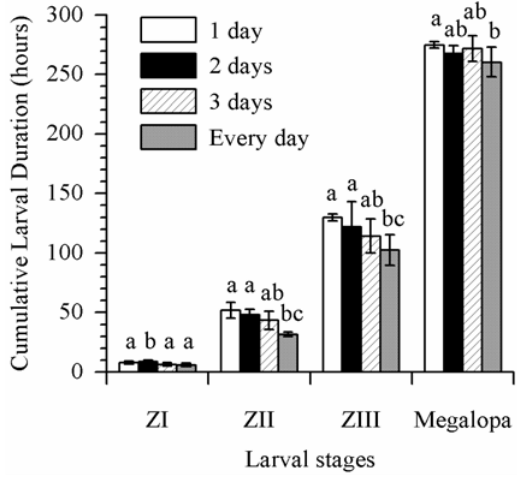
Fig. 5 – Cumulative larval duration in hours (CLD, average ± standard deviation) of Lepidophthalmus siriboia larvae reared in the laboratory and submitted to an initial feeding period. 1 day (treatment 1), 2 days (treatment 2), 3 days (treatment 3) and everyday (control treatment). Significant differences are represented by letters when P < 0 . 05 after Dunn’s test. Treatments with at least one same letter in common did not differ statistically (α = 0 , 05 ) . ZI, ZII, ZIII (zoeal stages).